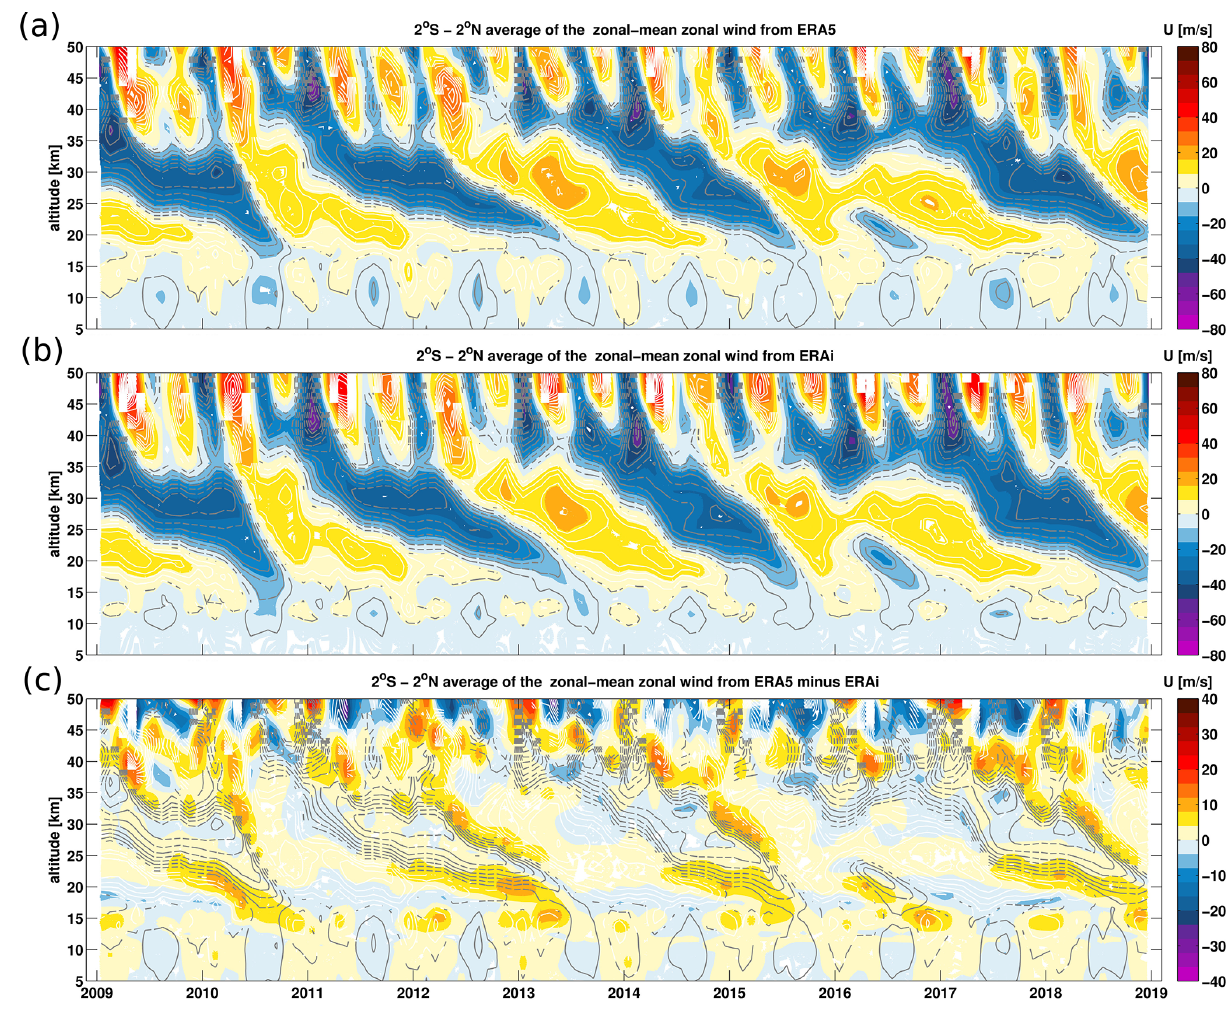
Figure 6. Tropical (2 ◦ S to 2 ◦ N average) zonal-mean zonal wind (in ms − 1 ) from the ERA5 reanalysis (a) , the ERA-Interim reanalysis (b) , and the difference between the ERA5 and the ERA-Interim reanalyses (c) as a function of time and